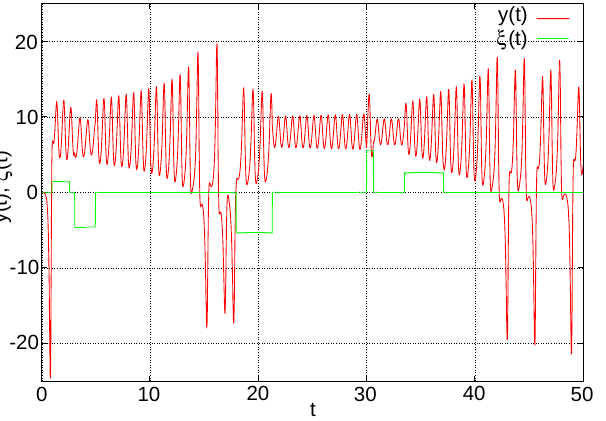
Figure 3. Result of simulation—Lorenz’s case with the influence of random structures: µ = 10, p = 3/8, T W = 5, T E = 5, ν = 2, σ = 5, x ( 0 ) = 0, y ( 0 ) = − 10 − 2 , h = 10 − 2